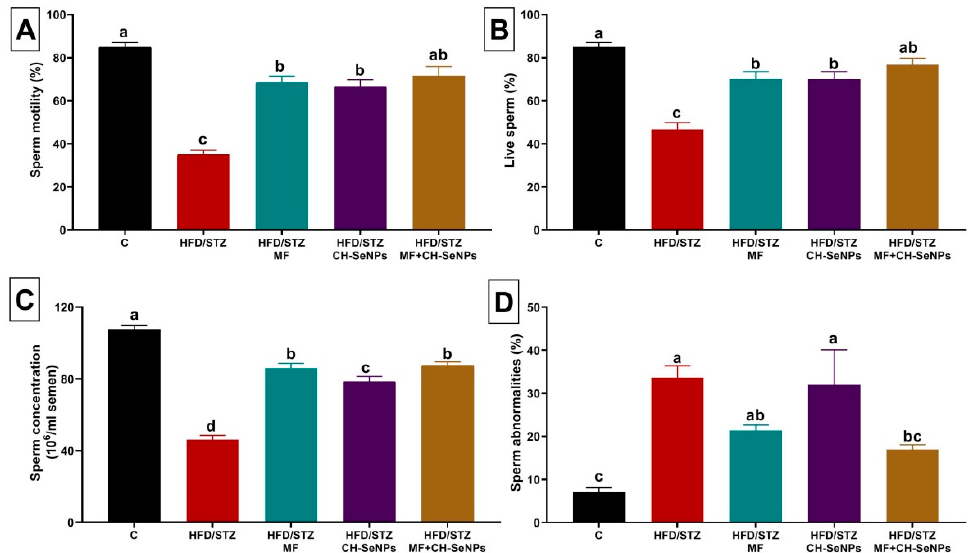
Figure 1. Effect of metformin (MF) and/or chitosan stabilized nanoparticles (CH-SeNPs) oral dosing for 60 days on sperm characteristics including ( A ) sperm motility, ( B ) live sperms, ( C ) sperm concentration, and ( D ) sperm abnormalities in high-fat diet/streptozotocin (HFD/STZ) diabetic male rats. Data expressed as mean ± SE, n = 15 for each group. Each bar carrying different letters (a, b, c, and d) was significantly different at p < 0.05.